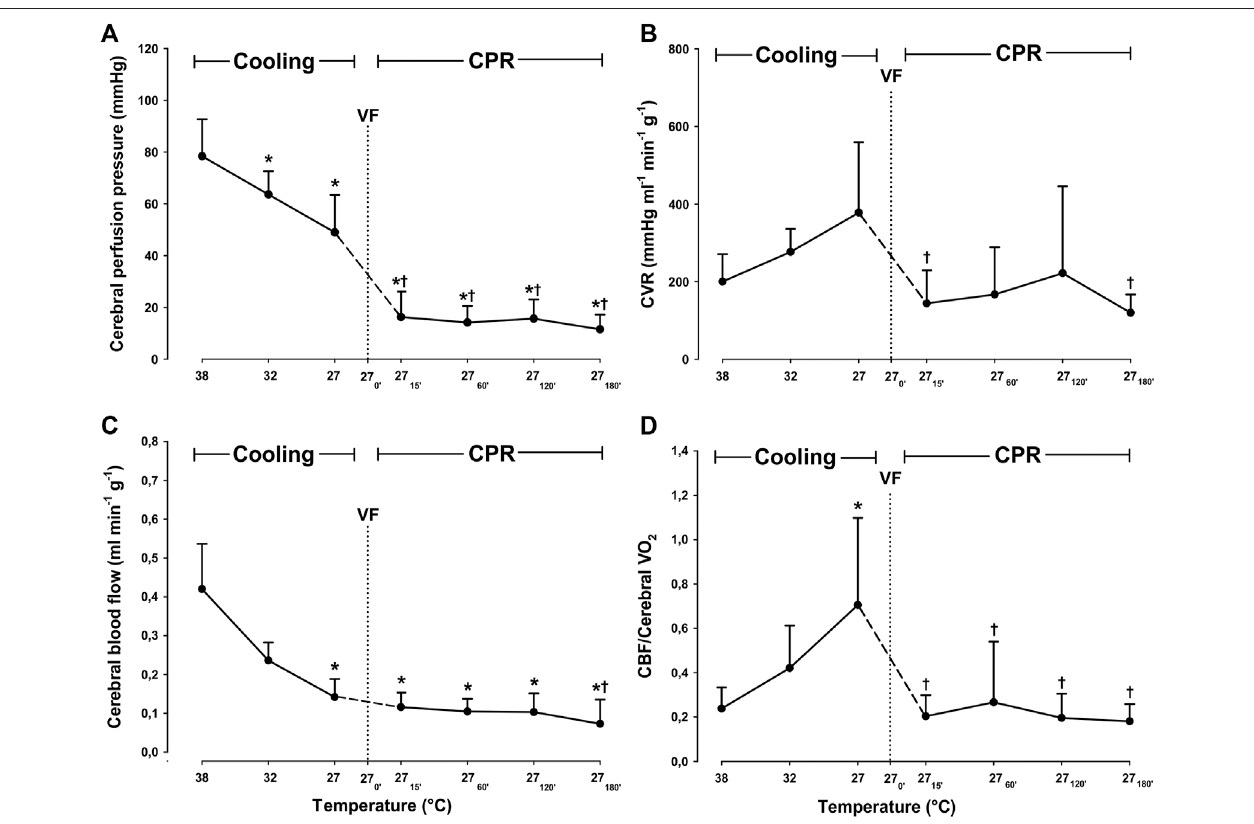
FIGURE 4 | Determinants of cerebral autoregulation, during cooling and 3 h CPR at 27 ° C. (A) cerebral perfusion pressure, (B) cerebral vascular resistance (CVR), (C) mean cerebral blood fl ow (CBF), (D) CBF/cerebral O 2 consumption ratio. Values are mean ± SD ( n = 8). * p < 0.05 vs. intragroup 38 ° C baseline; † p < 0.05 vs. intragroup spontaneous circulation at 27 °